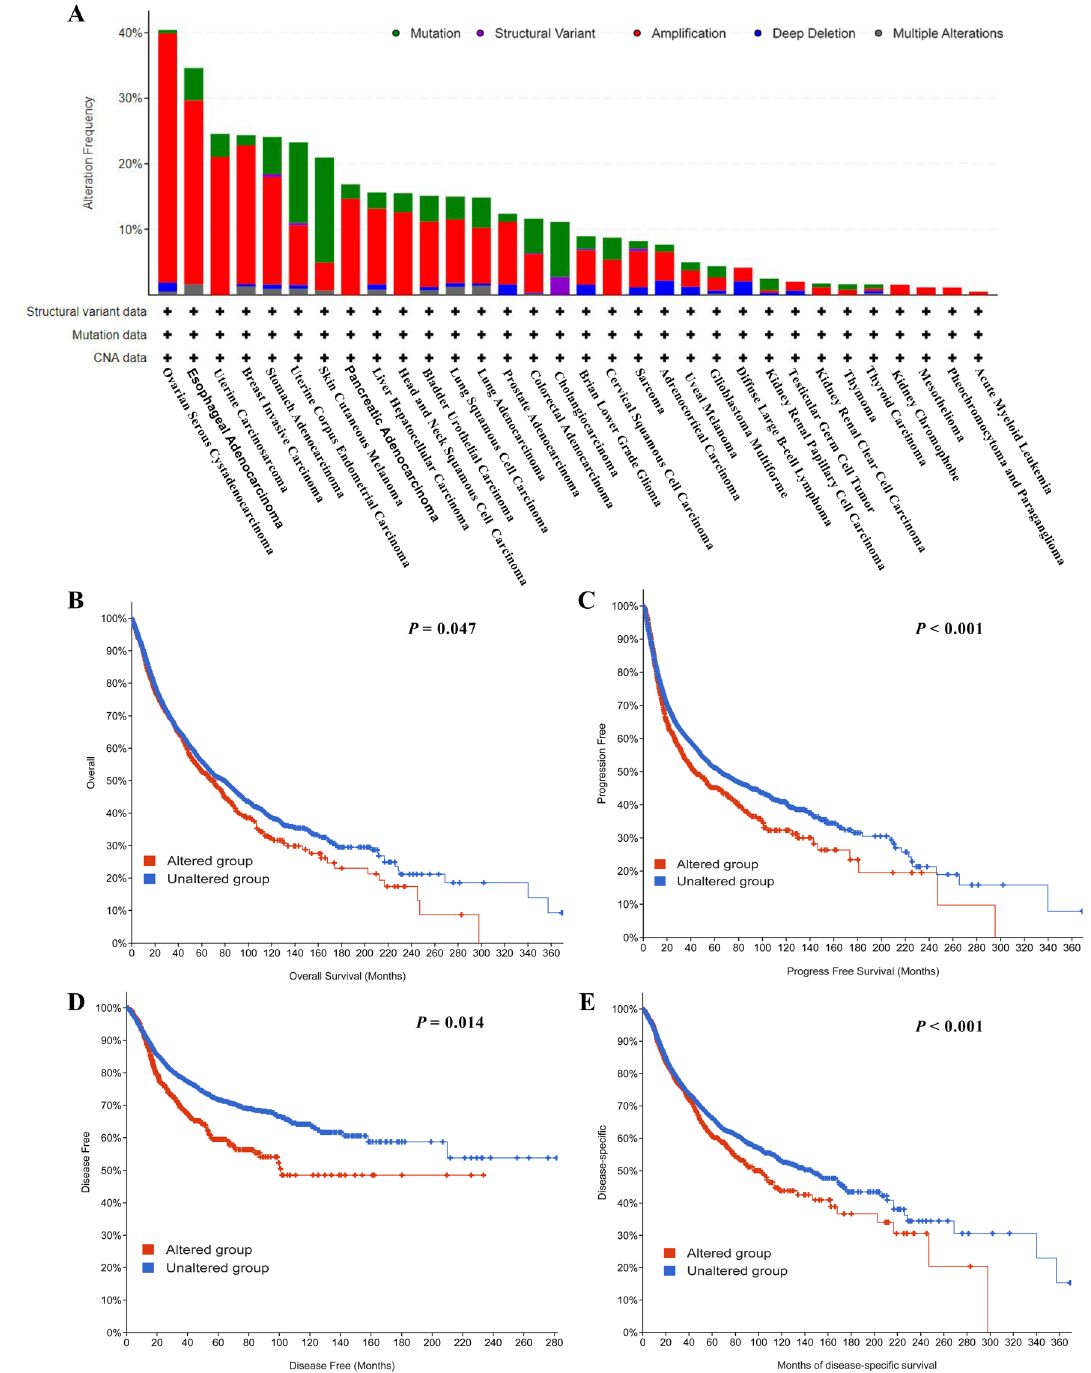
Figure 6. Genetic alteration analysis of the gasdermin family gene in pan-cancer. The genetic alteration type and frequency of the gasdermin family gene in pan-cancer ( A ). The potential correlations of the gene mutation status with overall survival ( B ), progression-free survival ( C ), disease-free survival ( D ), and disease-specific survival ( E